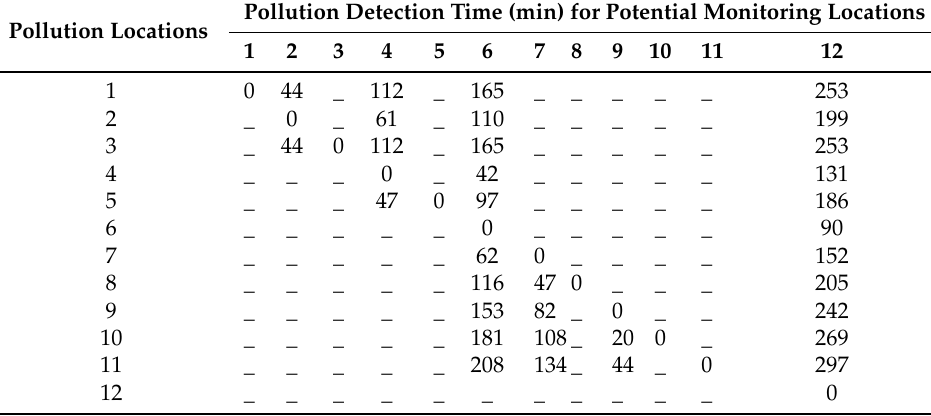
Table 3. Pollution detection time with a detection threshold of 1